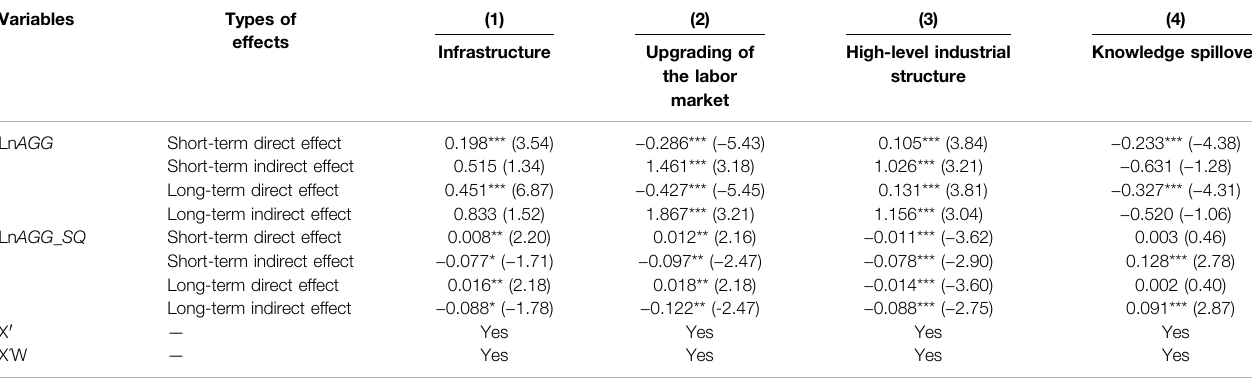
TABLE 6 | The results of the mediating effect test.